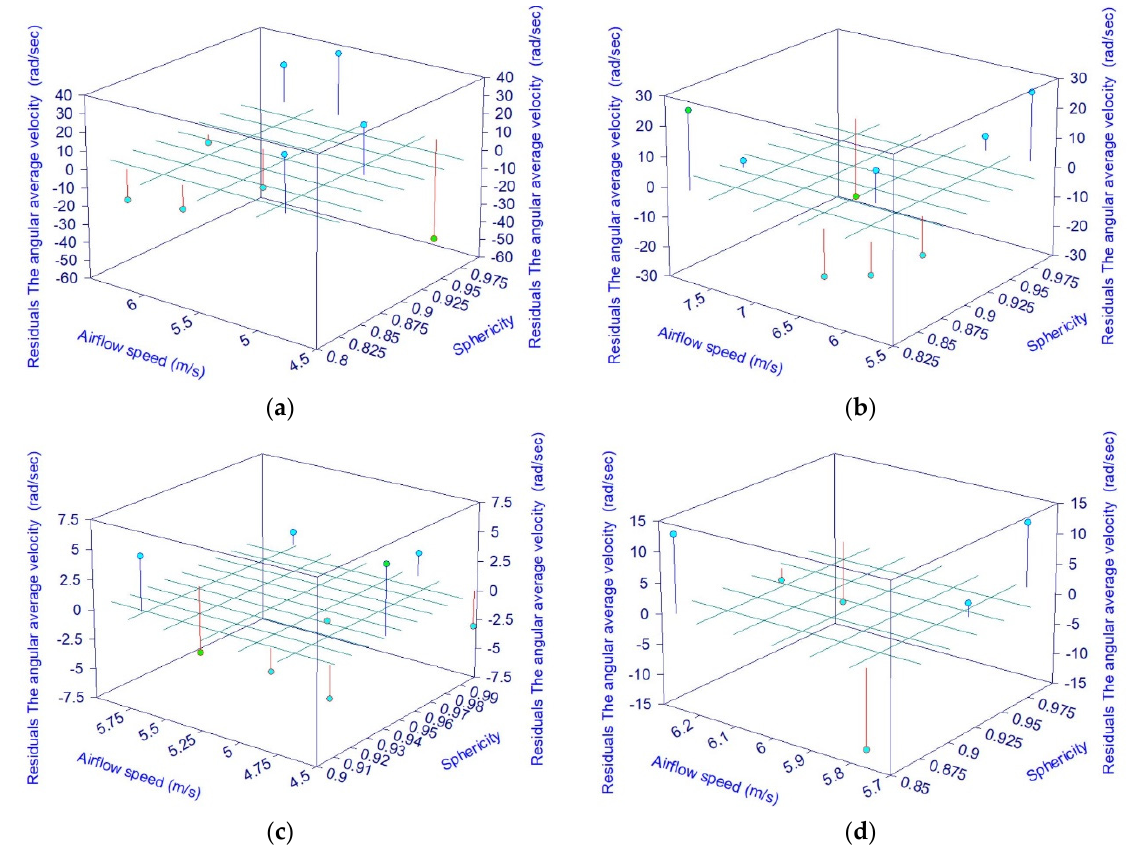
Figure 13. The residual graphs corresponding to the variation in the average angular velocity [44]: ( a ) a particle measuring 27 mm in diameter; ( b ) a particle measuring 35 mm in diameter; ( c ) a particle measuring 47 mm in diameter; ( d ) a particle measuring 56 mm in diameter.